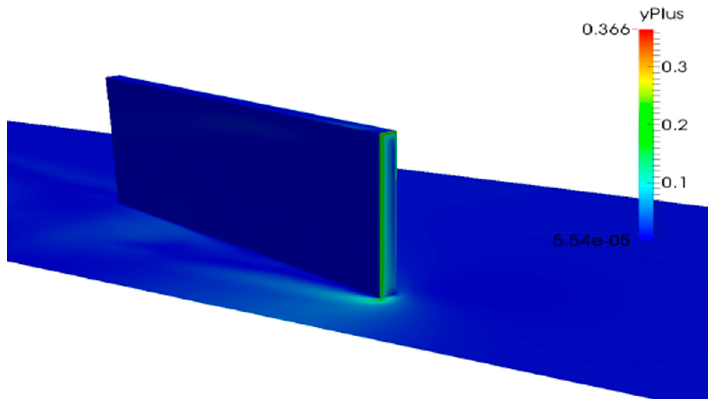
Figure 5. Wall y+ field distribution on the VG and bottom walls.